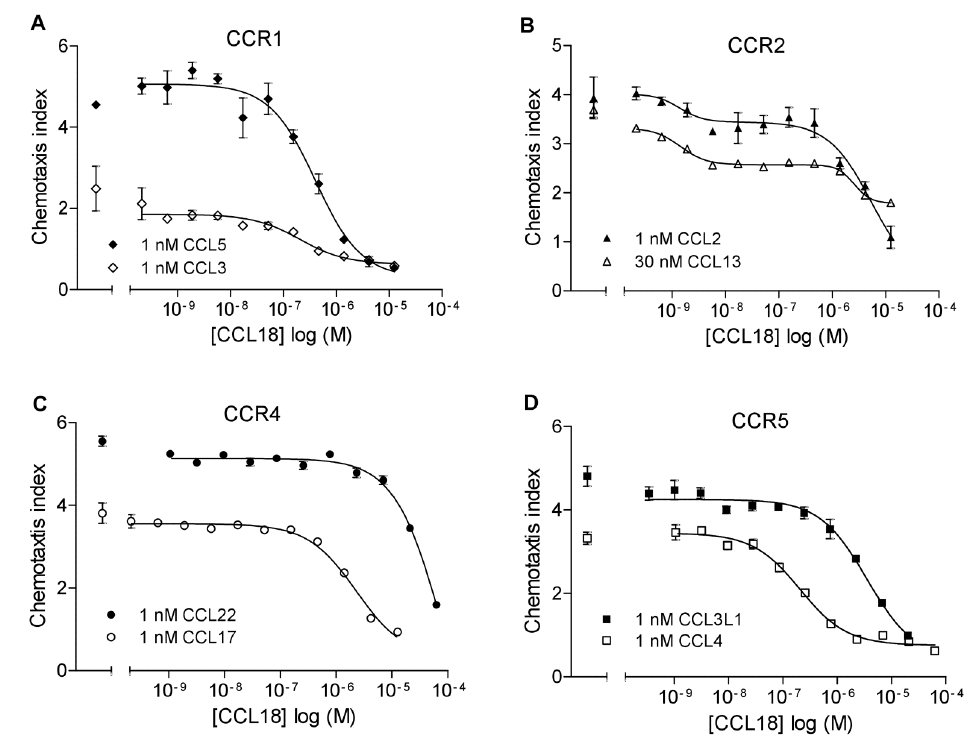
Figure 3. CCL18 inhibits CCR1, CCR2, CCR4 and CCR5-mediated chemotactic responses. A) Inhibition of 1 nM CCL5 (IC 403.3 nM) and 1 nM CCL3 (IC : 263.1 nM) mediated chemotactic responses of 300.19/CCR1 transfectants. B) Inhibition of 1 nM 50 CCL2 (IC : 1.38 nM and 5.3 µM) and 30 nM CCL13 (IC : 1.43 nM and 2.58 µM) mediated chemotactic responses of 50 50